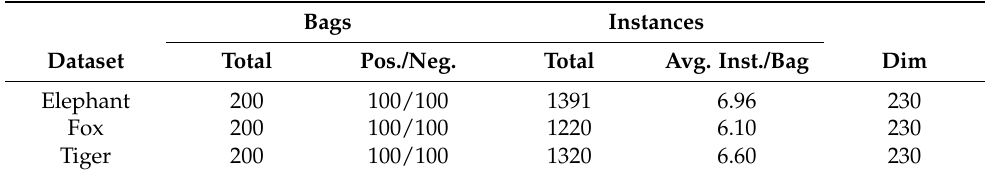
Table 2. Image datasets and the average number of instances per bag(Inst/Bag) for each dataset. Bags